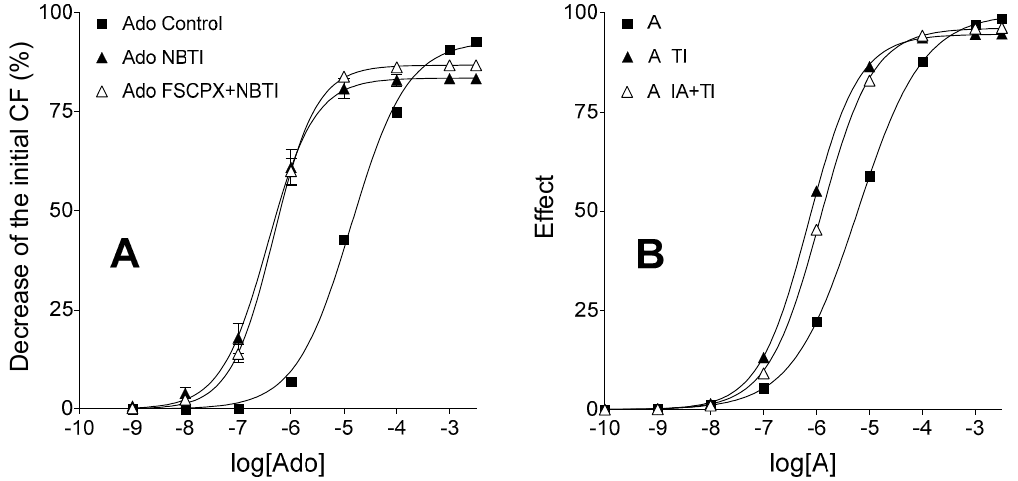
Figure 2. Ex vivo biological (panel A ) and in silico simulated (panel B ) models displaying E/c curves of an agonist with a short half-life, in the absence and presence of an agonist transport inhibitor, acting in systems with unaffected (filled symbols) and reduced (open symbols) receptor number. The real and the simulated agonist used to generate the E/c curves are both identical with the endogenous agonist of the given model that agonist is extensively transported and then eliminated. The x -axis denotes the common logarithm of the molar concentration of agonists (in the bathing medium), and the y -axis indicates the effect. The continuous lines represent the fitted Hill equation. On the panel A , symbols show mean ± SEM. Ado: adenosine; NBTI: a treatment with S-(2-hydroxy-5-nitrobenzyl)-6-thioinosine (an inhibitor of the nucleoside transporter type ENT1); FSCPX: a prior treatment with 8-cyclopentyl- N 3 -[3-(4-(fluorosulfonyl)benzoyloxy)propyl]- N 1 -propylxanthine (an irreversible A 1 adenosine receptor antagonist); A: agonist A (simulating adenosine); TI: a treatment with an inhibitor of agonist A transport (simulating the presence of NBTI); IA: a prior treatment with an irreversible antagonist (simulating an FSCPX pretreatment); CF: contractile force. Data of panel A are redrawn from [31].